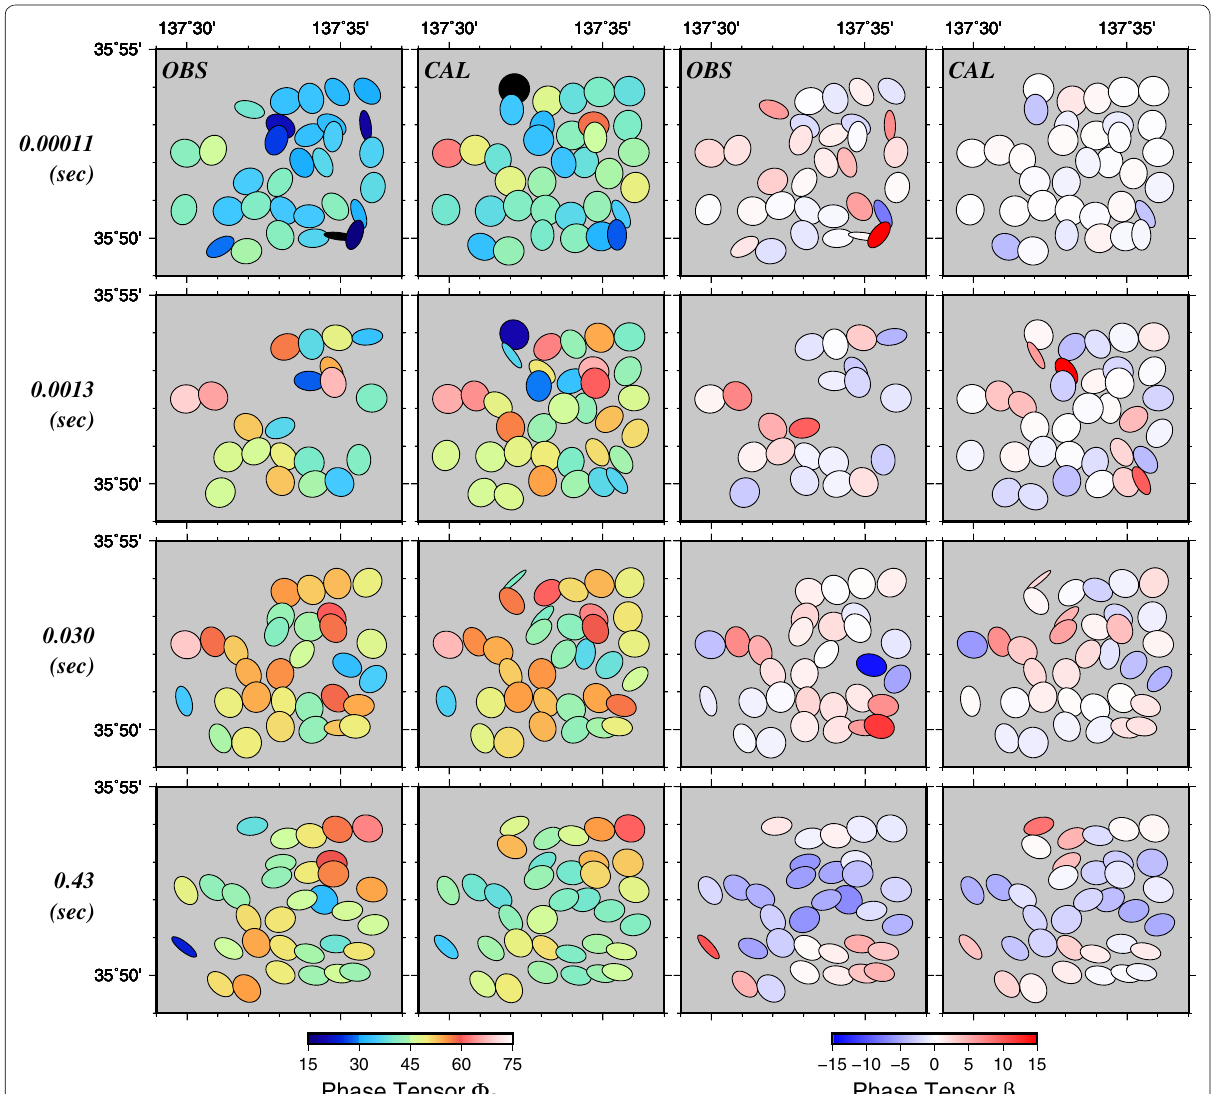
Fig. 3 Phase tensor ellipses based on observed impedance and model responses of the inverted resistivity model label as OBS and CAL,